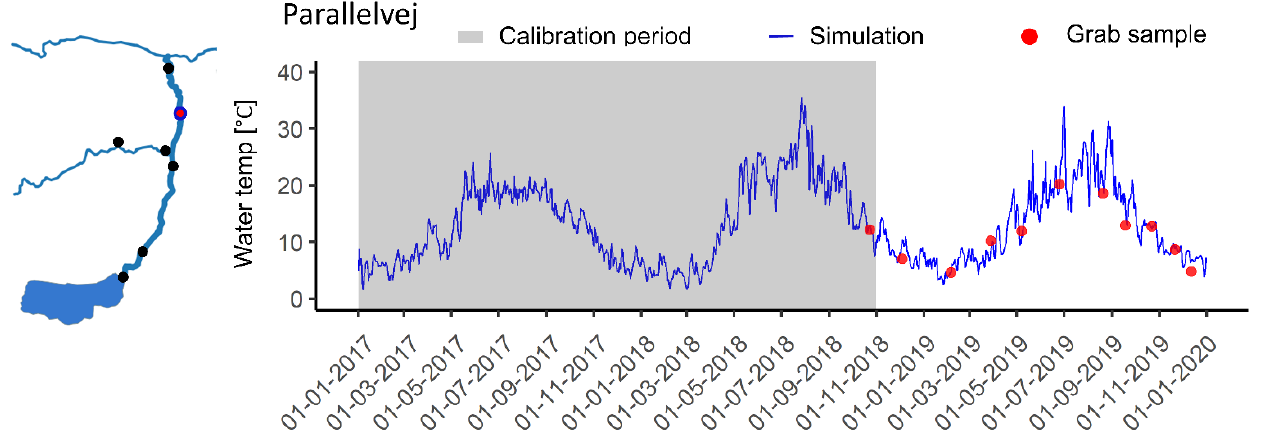
Figure 5. Simulation results for the stream temperature compared to grab sample measurements at Parallelvej (red marked circle in map). The grey ribbon indicates the calibration period for the RR model, the rest of the time series being the verification.